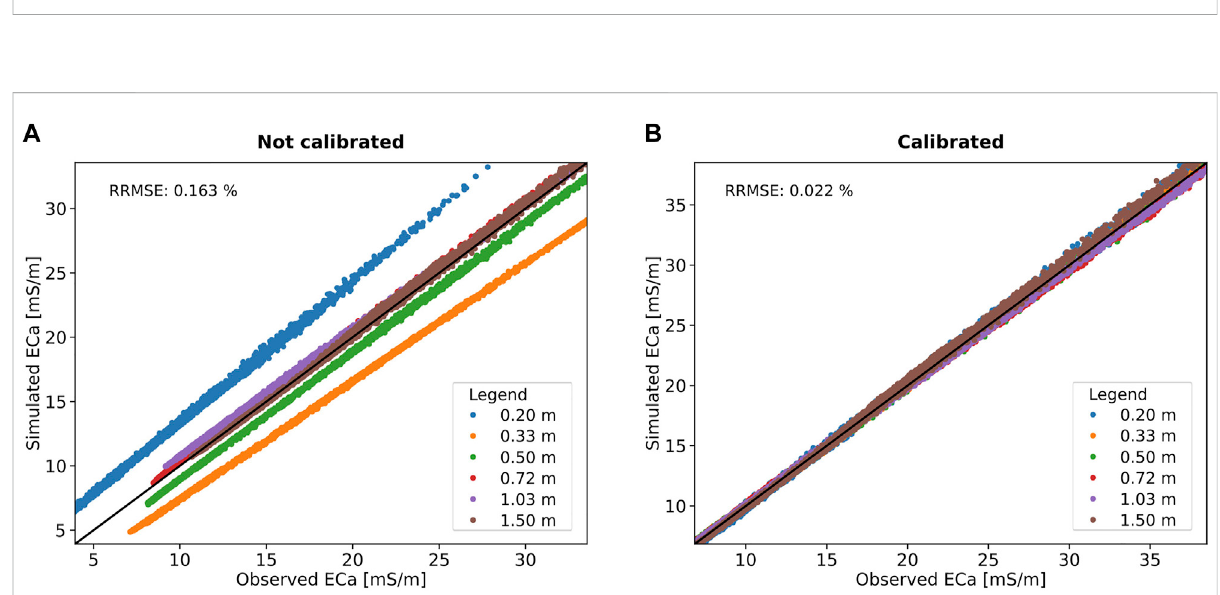
FIGURE 5 Mis fi tbetween modelled andmeasuredelectrical conductivity after inversion for theuncalibrated (A) and ERT-calibratedEMIdata (B) .Notethe much smaller mis fi t for all coil spacings in the calibrated